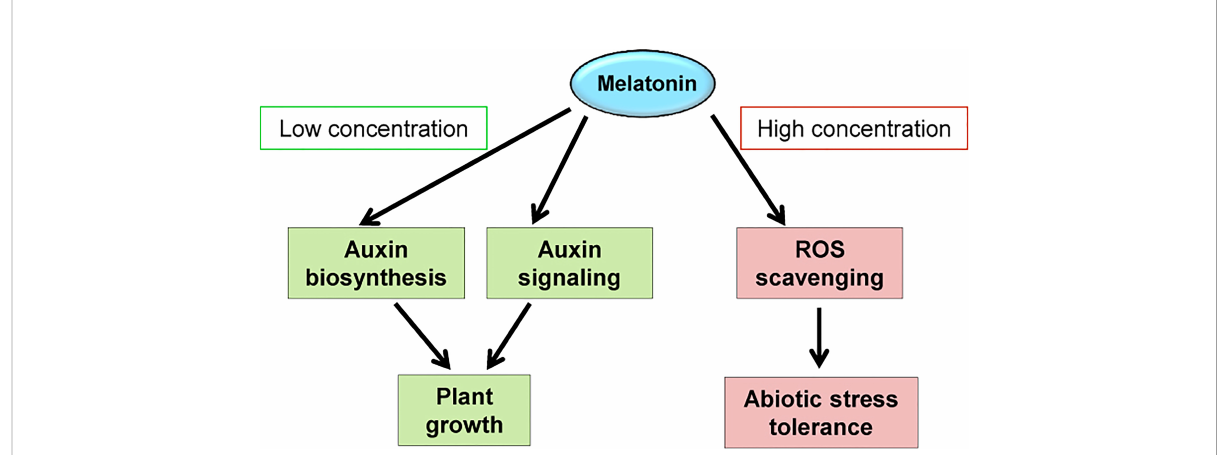
FIGURE 9 Possible working models of melatonin. The working models demonstrate the molecular changes that caused by exogenously applied